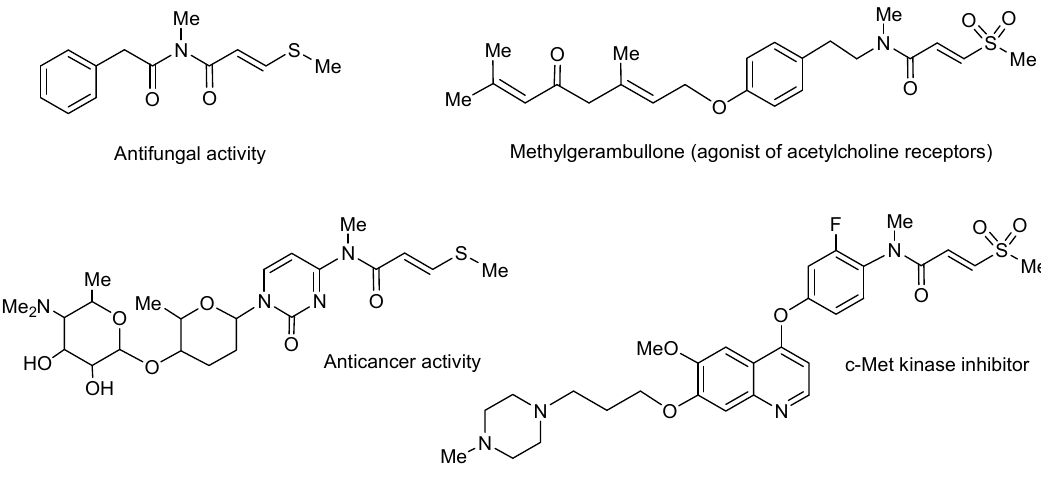
Figure 1. Known biologically active derivatives of vinyl sulfides containing the amide group (anticancer [28], antifungal [29], agonist of acetylcholine receptors [30], c-Met kinase inhibitor [31]).